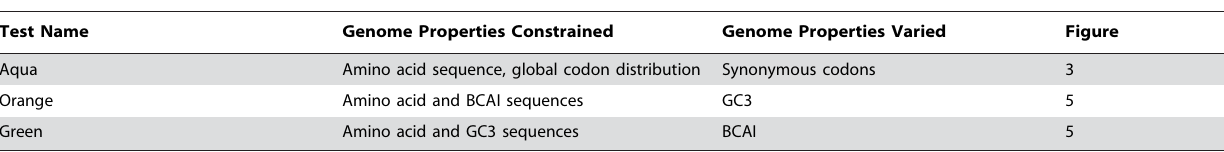
Table 1. Randomization test